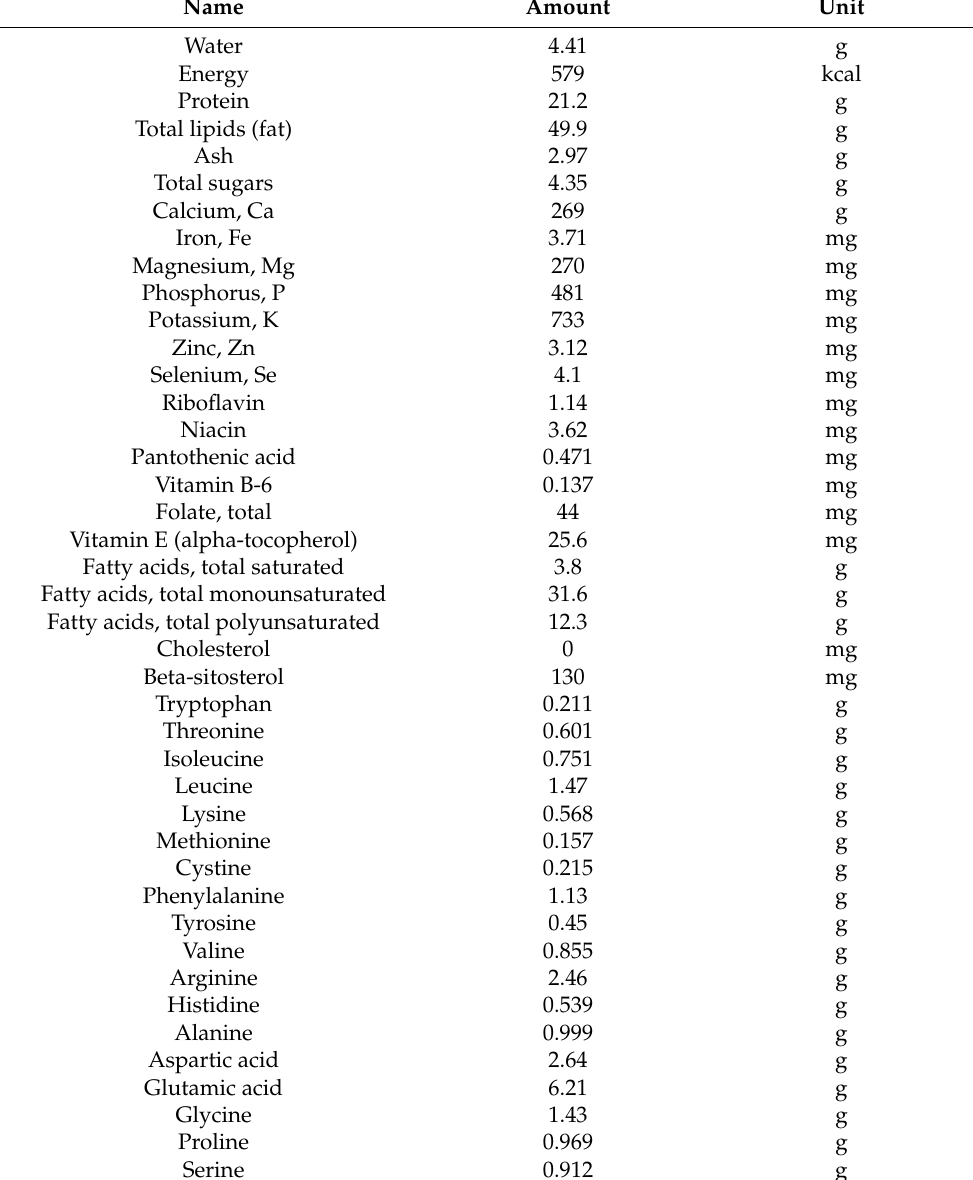
Table 2. Nutritional value of 100 g